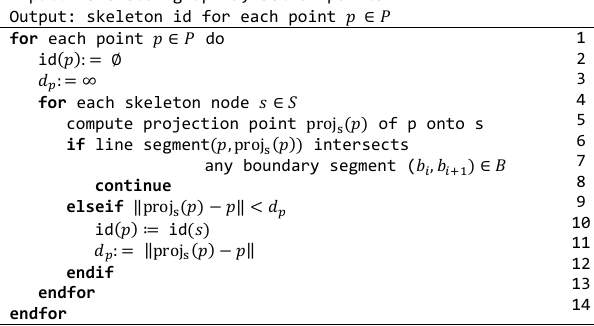
Algorithm 7. Each point is attached to the closest skeleton part while avoiding boundary intersections with ‖ ‖ as Euclidean distance in 2D and as the projection point of onto skeleton node .